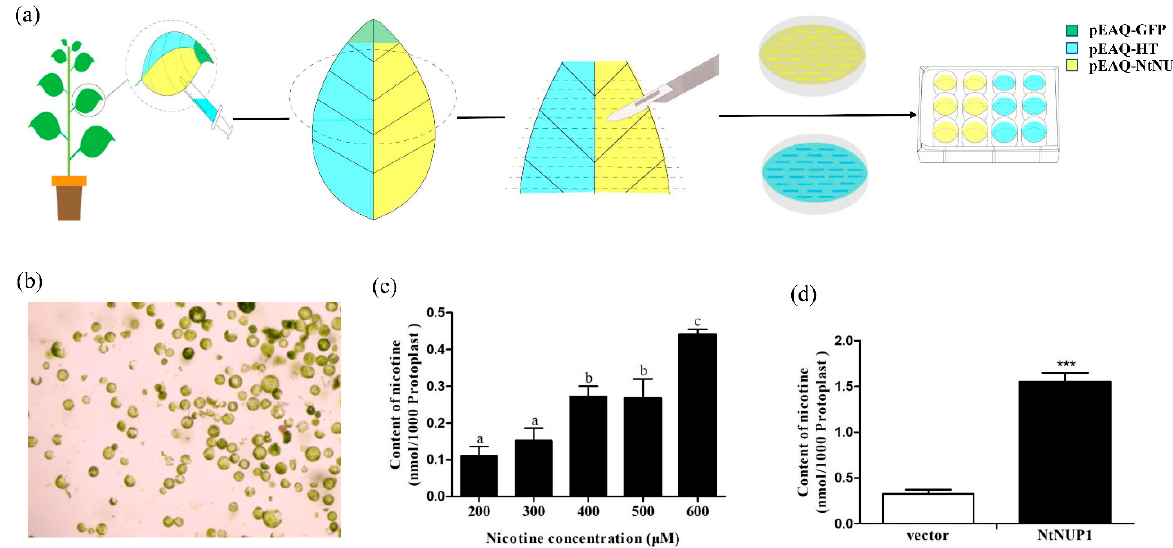
Figure 2. Uptake of nicotine by N. benthamiana leaf protoplasts expressing NtNUP1 . ( a ) Schematic diagram of the nicotine absorption test in N. benthamiana leaf protoplasts expressing NtNUP1. After the transient expression of pEAQ- NtNUP1 and pEAQ-HT in N. benthamiana for 2 days, leaf protoplasts were isolated. The protoplast suspension and nicotine were transferred to a tissue culture plate. Ten microliters of the supernatant were analyzed via LC-MS/MS. ( b ) The N. benthamiana leaf protoplasts prepared from leaves injected with different constructs. ( c ) Uptake of different concentrations of nicotine in untransformed wild-type leaf protoplasts. ( d ) Uptake of 500 µ M nicotine by leaf protoplast expressing the pEAQ-HT control and pEAQ- NtNUP1 . The data are presented as the means ± standard deviations ( n = 3) (*** p ≤ 0.001, the different letters mean significant differences).